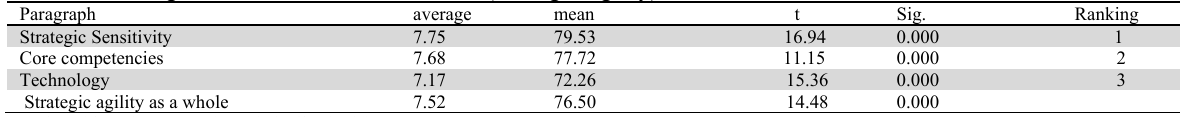
Table 4 Arithmetic averages and T test results for all areas (Strategic Agility)